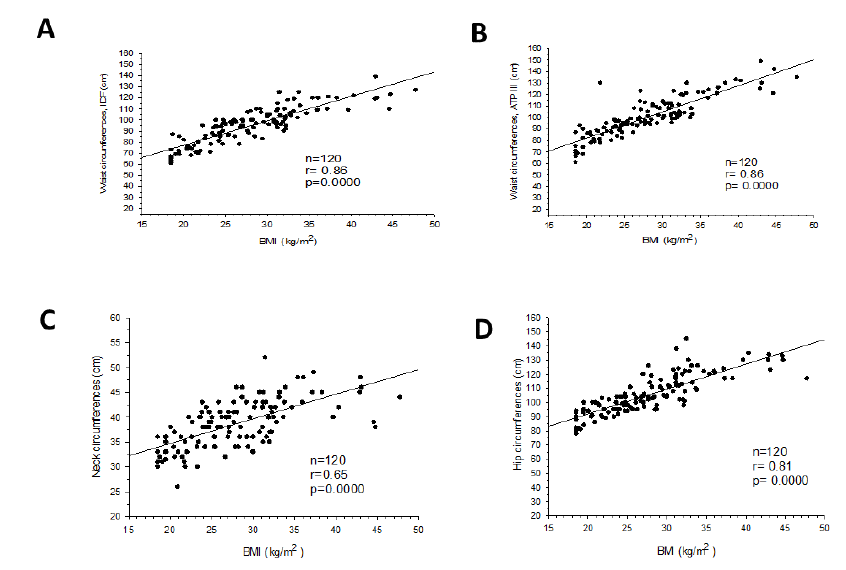
Figure 2. Correlation between body mass index (BMI) and waist circumference according to: